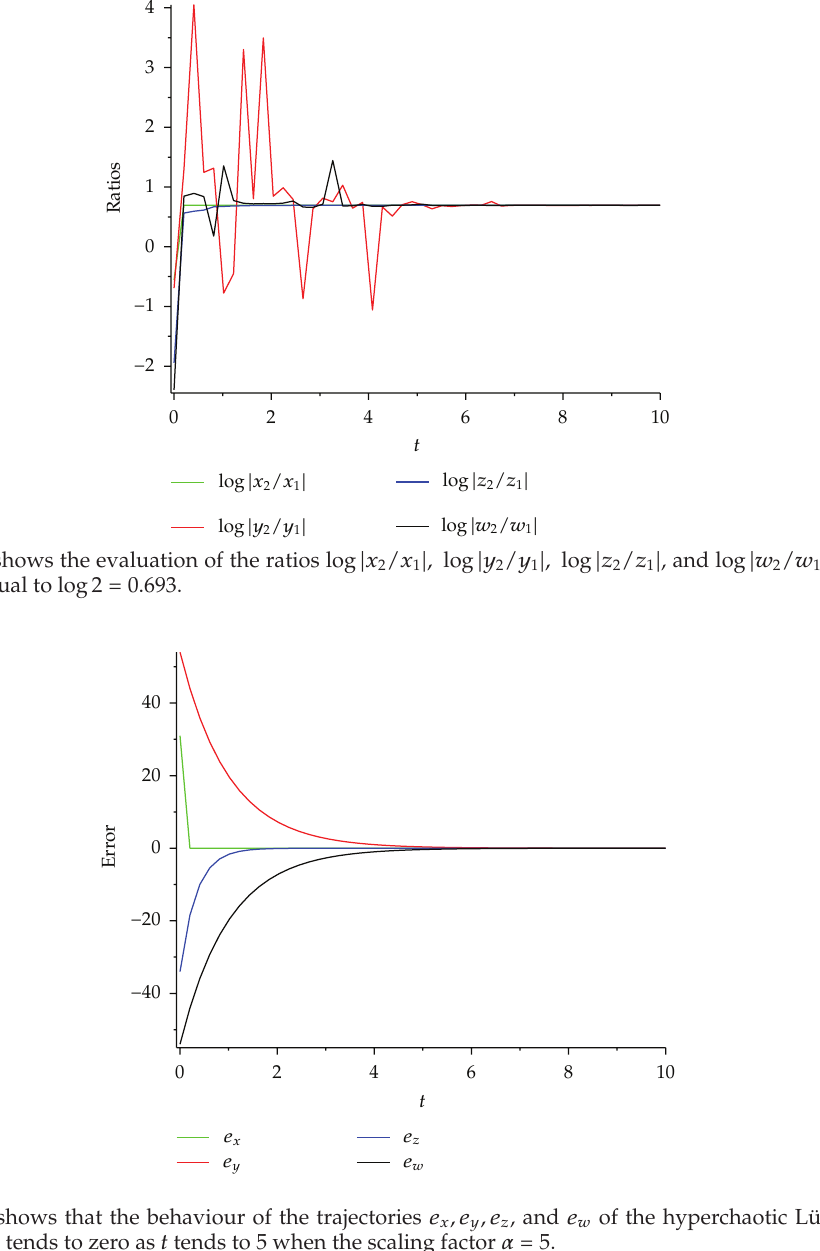
Choosing α (cid:8) − 2 then the error system (cid:6) 5.4 (cid:7) has the initial values e x (cid:6) 0 (cid:7) (cid:8) − 18, e y (cid:6) 0 (cid:7) (cid:8) − 30 , e z (cid:6) 0 (cid:7) (cid:8) − 13, and e w (cid:6) 0 (cid:7) (cid:8) 21. Figure 7 shows that the trajectories of e x (cid:6) t (cid:7) , e y (cid:6) t (cid:7) , e z (cid:6) t (cid:7) , and e w (cid:6) t (cid:7) tended to zero after t ≥ 5. Figure 8 shows the evaluation of the ratios log | x 2 /x 1 | , log | y 2 /y 1 | , log | z 2 /z 1 | , and log | w 2 /w 1 | whose limits are equal to log 2 (cid:8) 0 . 693. Choosing α (cid:8) 5 then the error system (cid:6) 5.4 (cid:7) has the initial values e x (cid:6) 0 (cid:7) (cid:8) 31 , e y (cid:6) 0 (cid:7) (cid:8) 54 , e z (cid:6) 0 (cid:7) (cid:8) − 34, and e w (cid:6) 0 (cid:7) (cid:8) − 54. Figure 9 shows that the trajectories of e x (cid:6) t (cid:7) , e y (cid:6) t (cid:7) , e z (cid:6) t (cid:7)